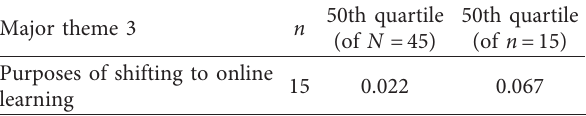
Table 7: 50th quartiles for purposes of shifting to online